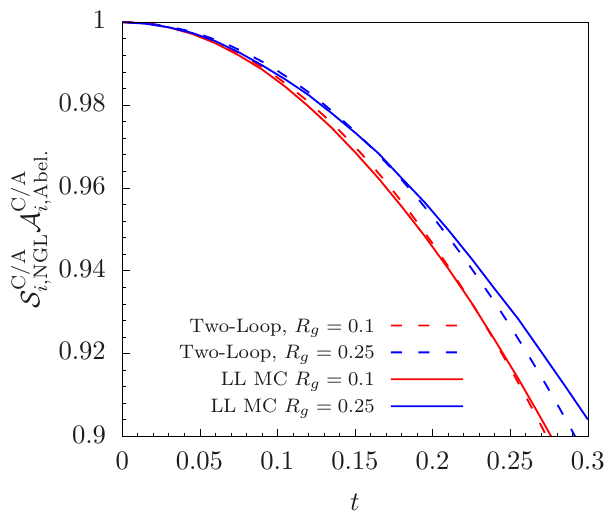
Figure 4 . The NGL+clustering distribution at large- N c at LL (overall accuracy NLL) for an initial fundamental (quark) dipole, comparing the two-loop results of eq. (2.42) and eq. (2.46), with C F C A = 2, to the all orders resummation at groomed angles R g = 0 : 25 and 0 : !